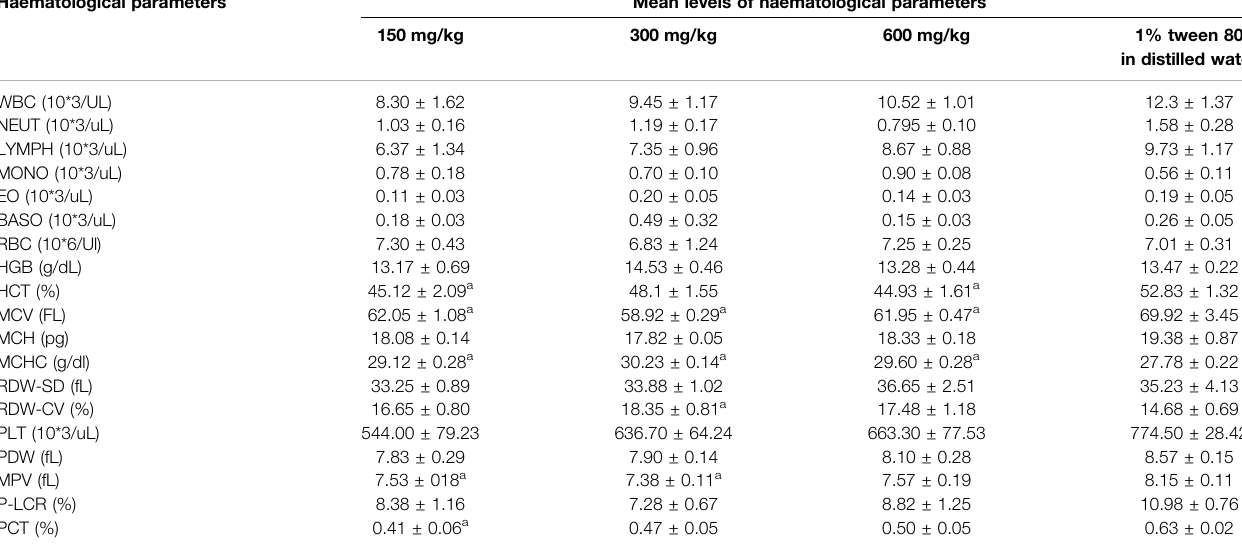
TABLE 4 | Mean levels of hematological parameters after 28 days at different doses of the extract. Haematological